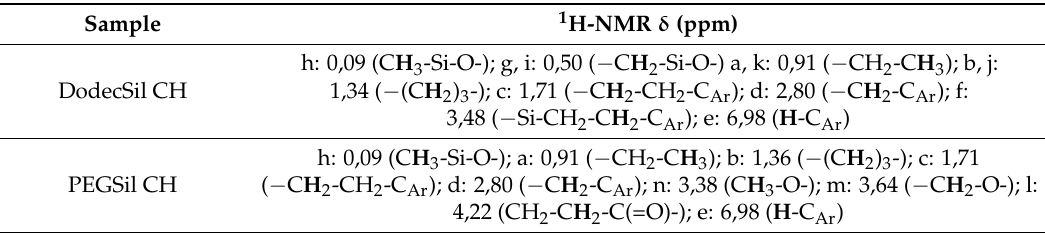
Table 1. Assignments of the 1 H-Nuclear Molecular Resonance (NMR) of DodecSil CH and PEGSil CH signals.